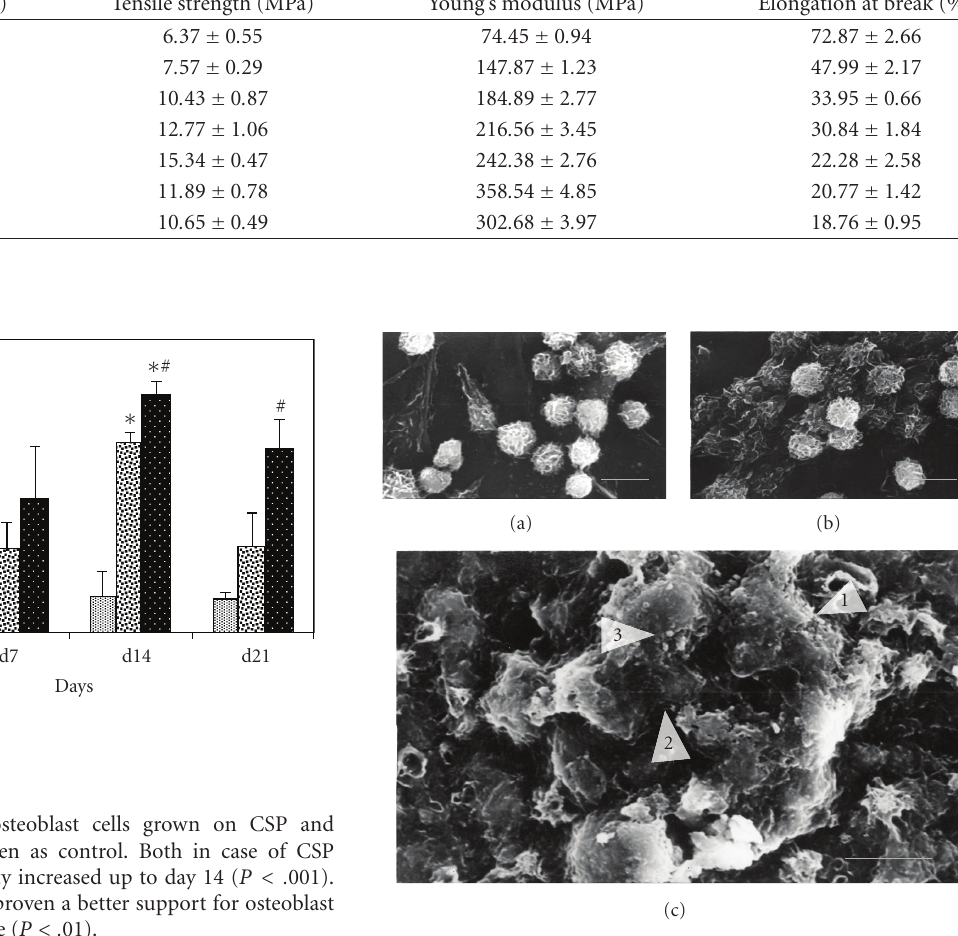
Figure 8: SEM images of osteoblasts grown on di ff erent matrices at day 14 on (a) chitosan (CS), (b) chitosan phosphate (CSP), (c) HAp/CSP nanocomposite. Scale bar of each image is 10 μ m. Arrow “1” shows a nodular cell aggregate, arrow “2” shows the extracellular matrix secreted by the cells in around themselves, and arrow “3” shows a visible mineral